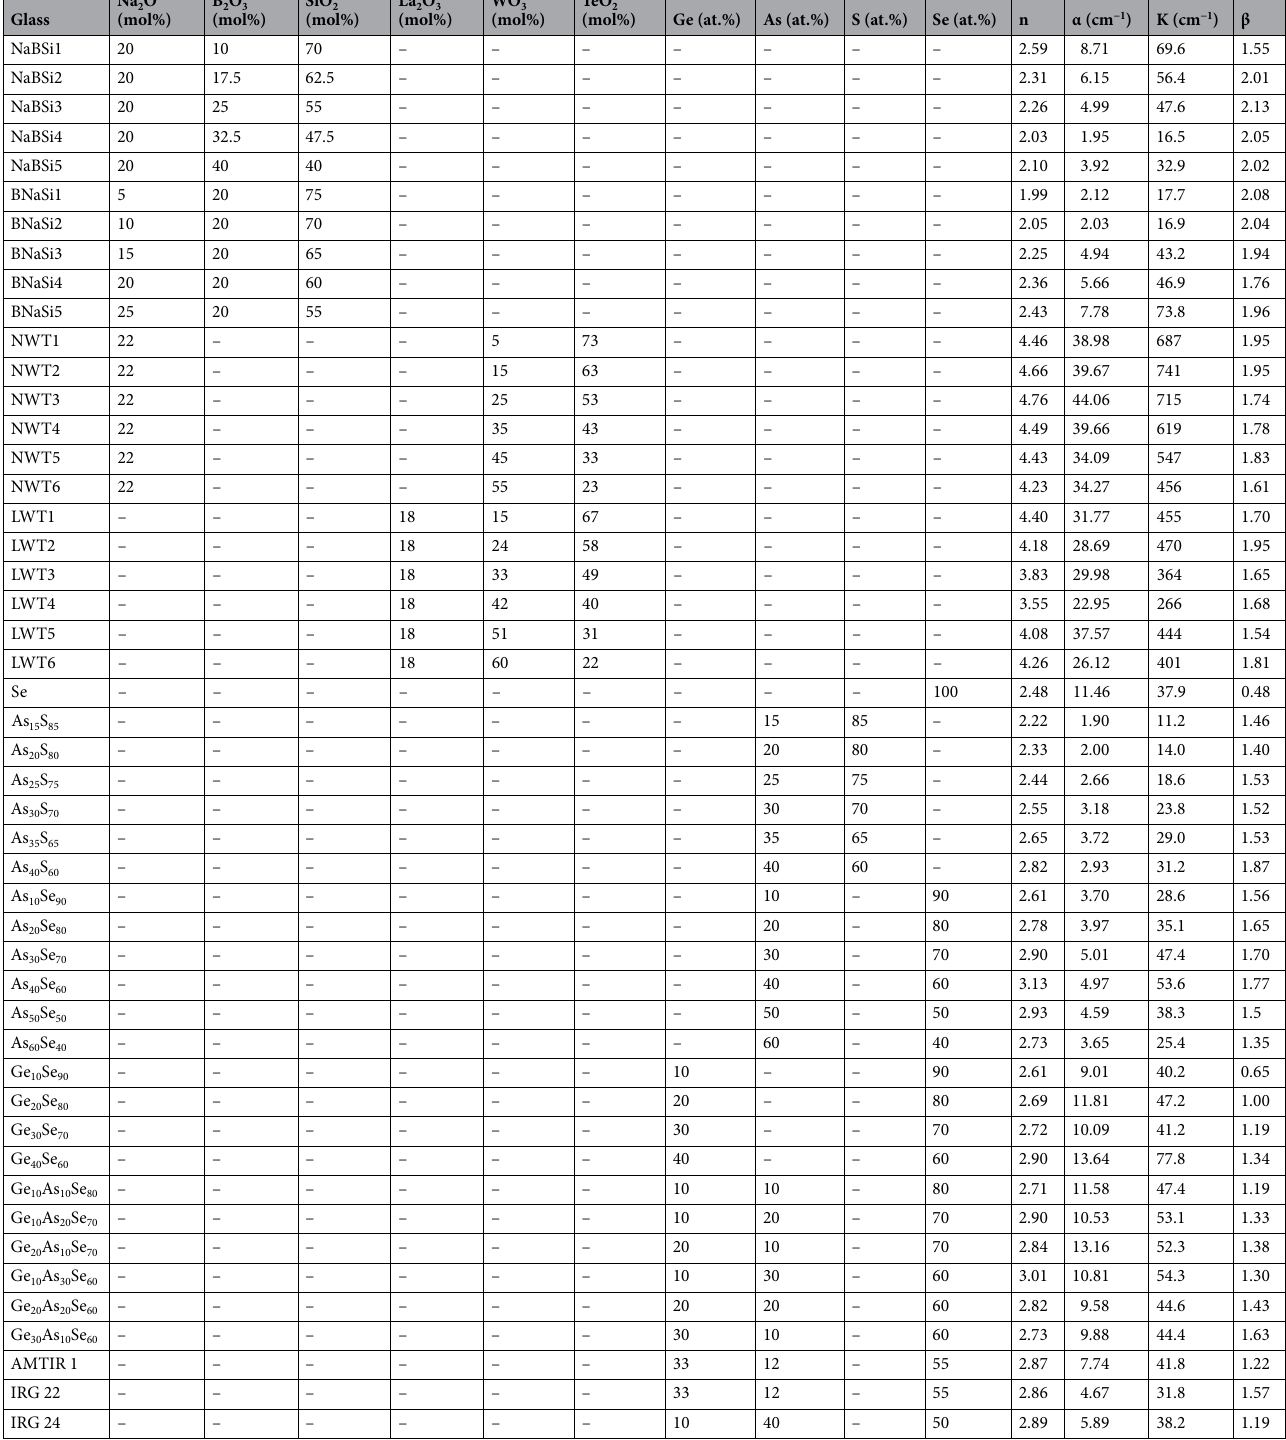
Table 1. Experimental (nominal) borosilicate, tellurite, and chalcogenide glass compositions, THz refractive indices (n) and absorption coefficients (α) at 0.5 THz, and the K and β fitting parameters to power-law relation, n α = K × f β , for all studied